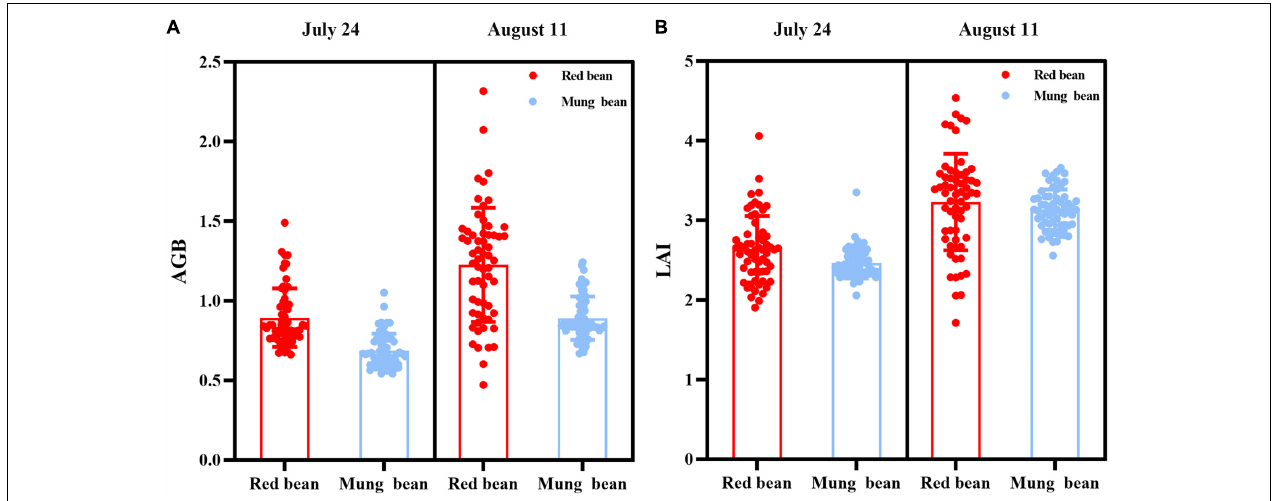
FIGURE 2 | The ground-truth data for leaf area index (LAI) and aboveground biomass (AGB) of intercropping crops. (A) AGB of red bean and mung bean; (B) LAI of red bean and mung bean.